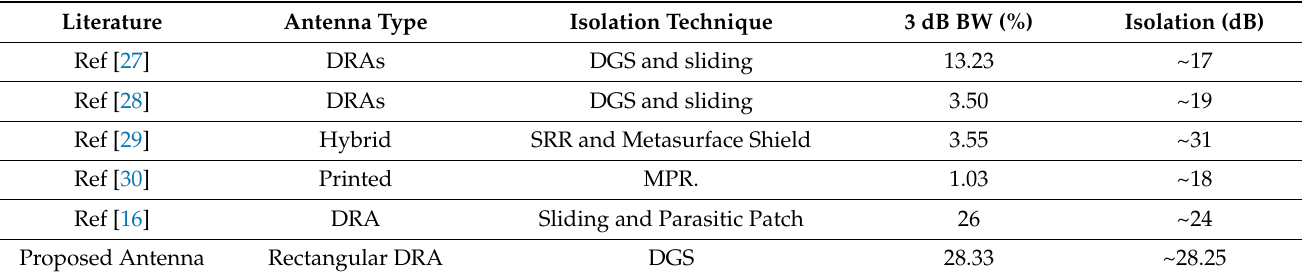
Table 6. Comparisons with other MIMO antennas on the basis of CP.